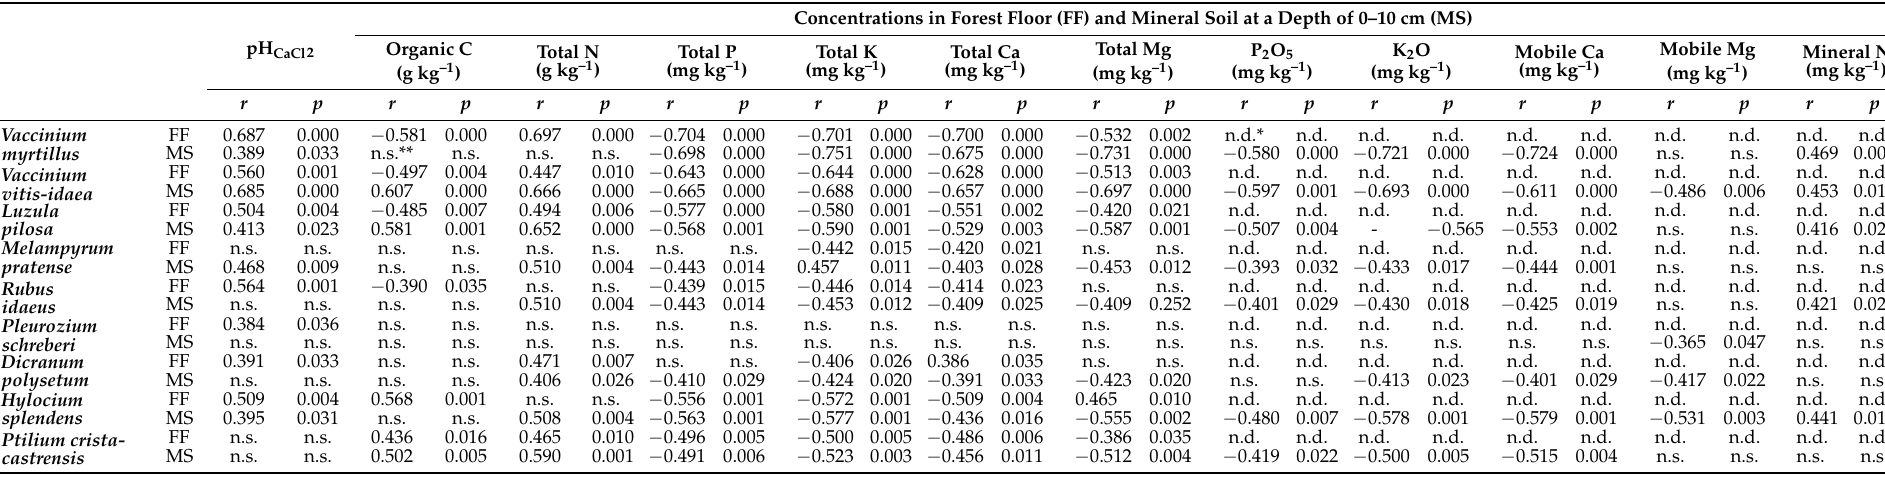
Table 5. Relations between the cover of ground vegetation species and forest floor (FF) and mineral soil (MS) chemical parameters (Pearson’s r and p -value). Concentrations in Forest Floor (FF) and Mineral Soil at a Depth of 0–10 cm pH CaCl2